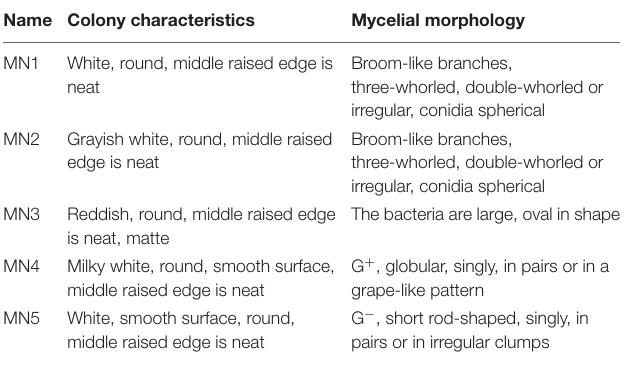
TABLE 4 | Colony characteristics and morphology of isolated strains from Mianning ham. Name Colony characteristics